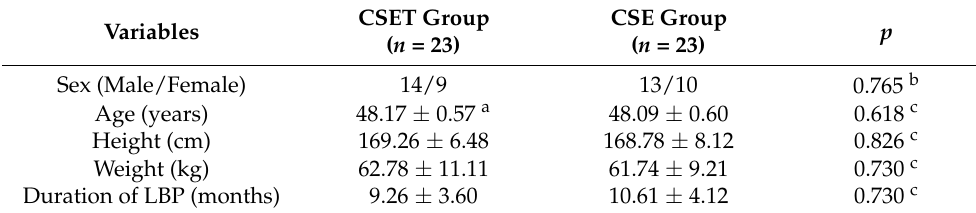
Table 1. General characteristics of the subjects ( n = 46).